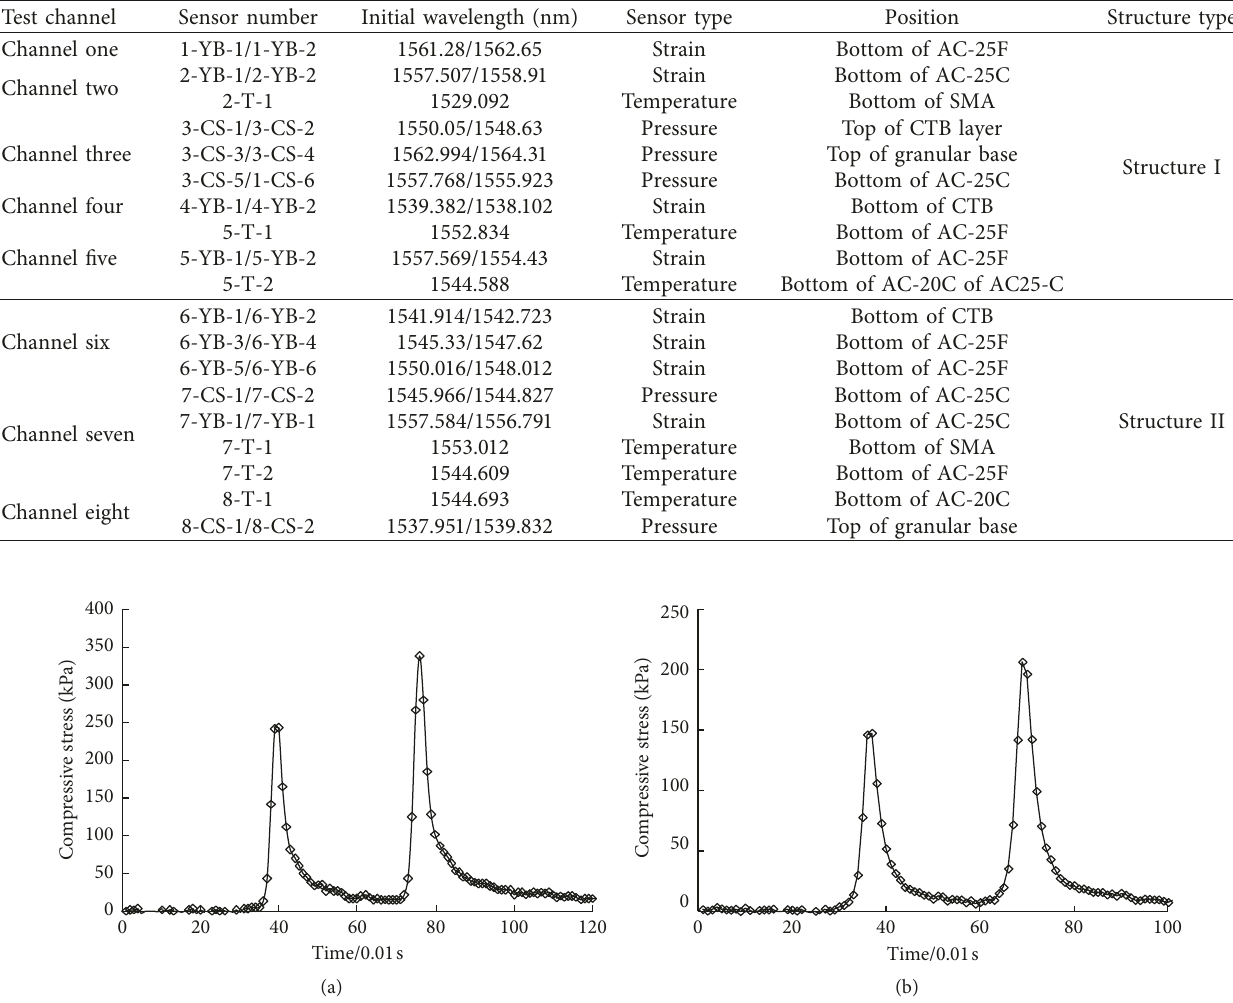
Figure 6: Vertical compressive stress at the top of AC-25F. (a) Structure I. (b) Structure II.